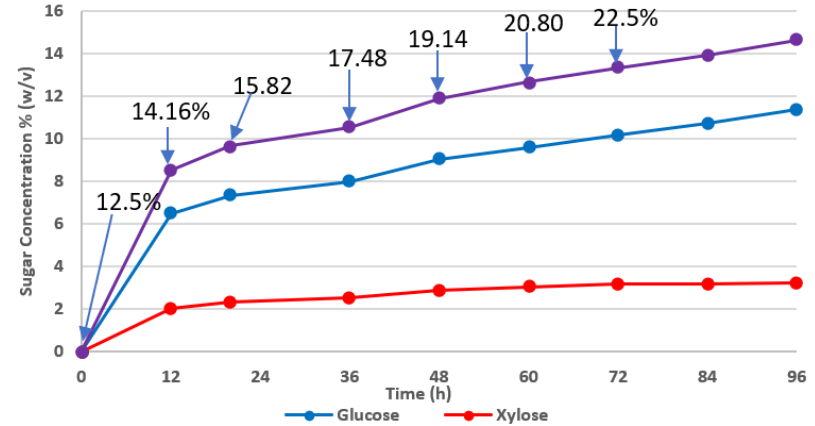
Figure 2. Total sugars released during fed ‐ batch addition of dry paper to reach 22.5% solids with 3.75 FPU/g DS Cellic CTEC 3 . Numbers on the graph indicate the total percentage of solids added during fed ‐ batch with dried material.